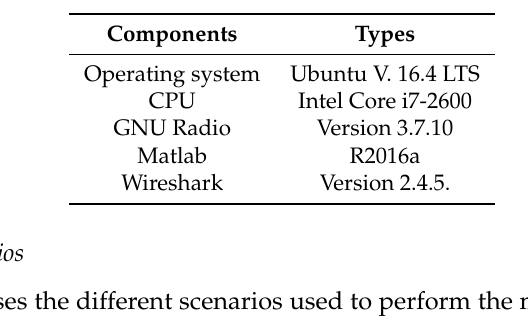
Table 2. Overview of the software used to verify the transceiver